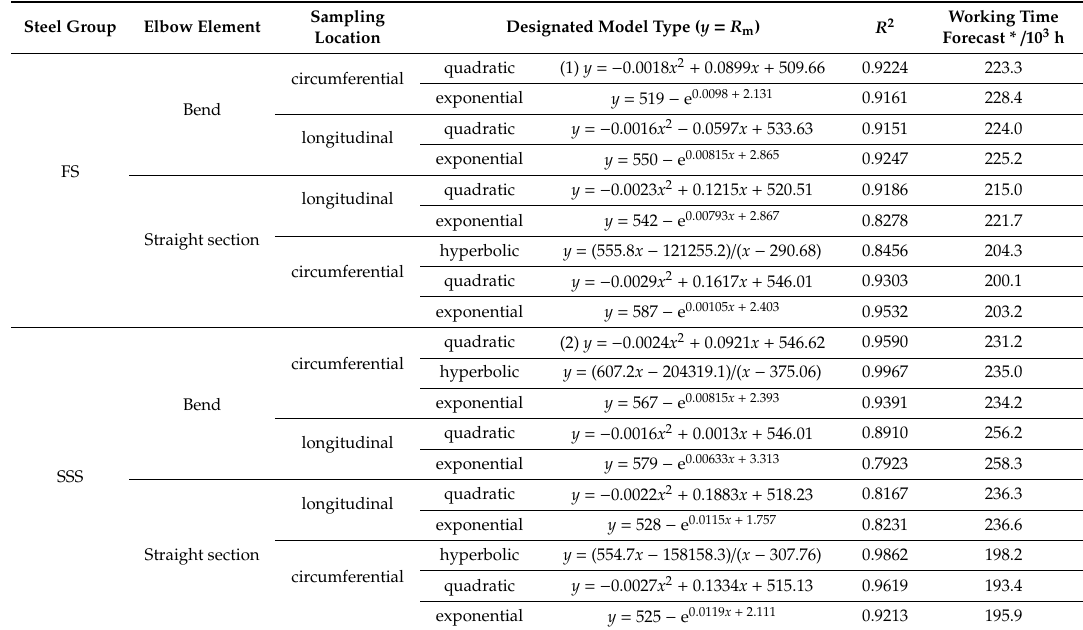
Table 1. Summary set of prognostic models of R m for FS and secondarily super-heated steam (SSS) steel groups